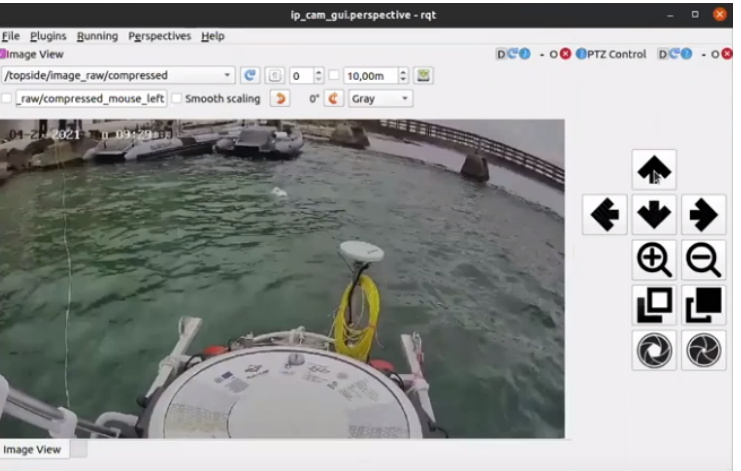
Figure 10. User interface of the catamaran’s surveillance pan-tilt-zoom camera. System integration tests in Split, Croatia in April 2021. Blueye ROV is visible just in front of the